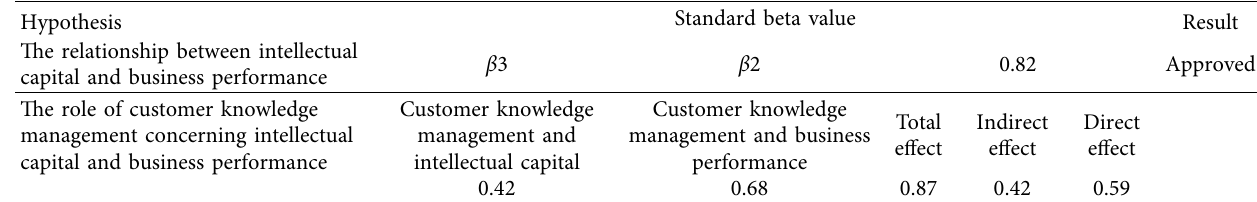
Table 10: Test of mediating